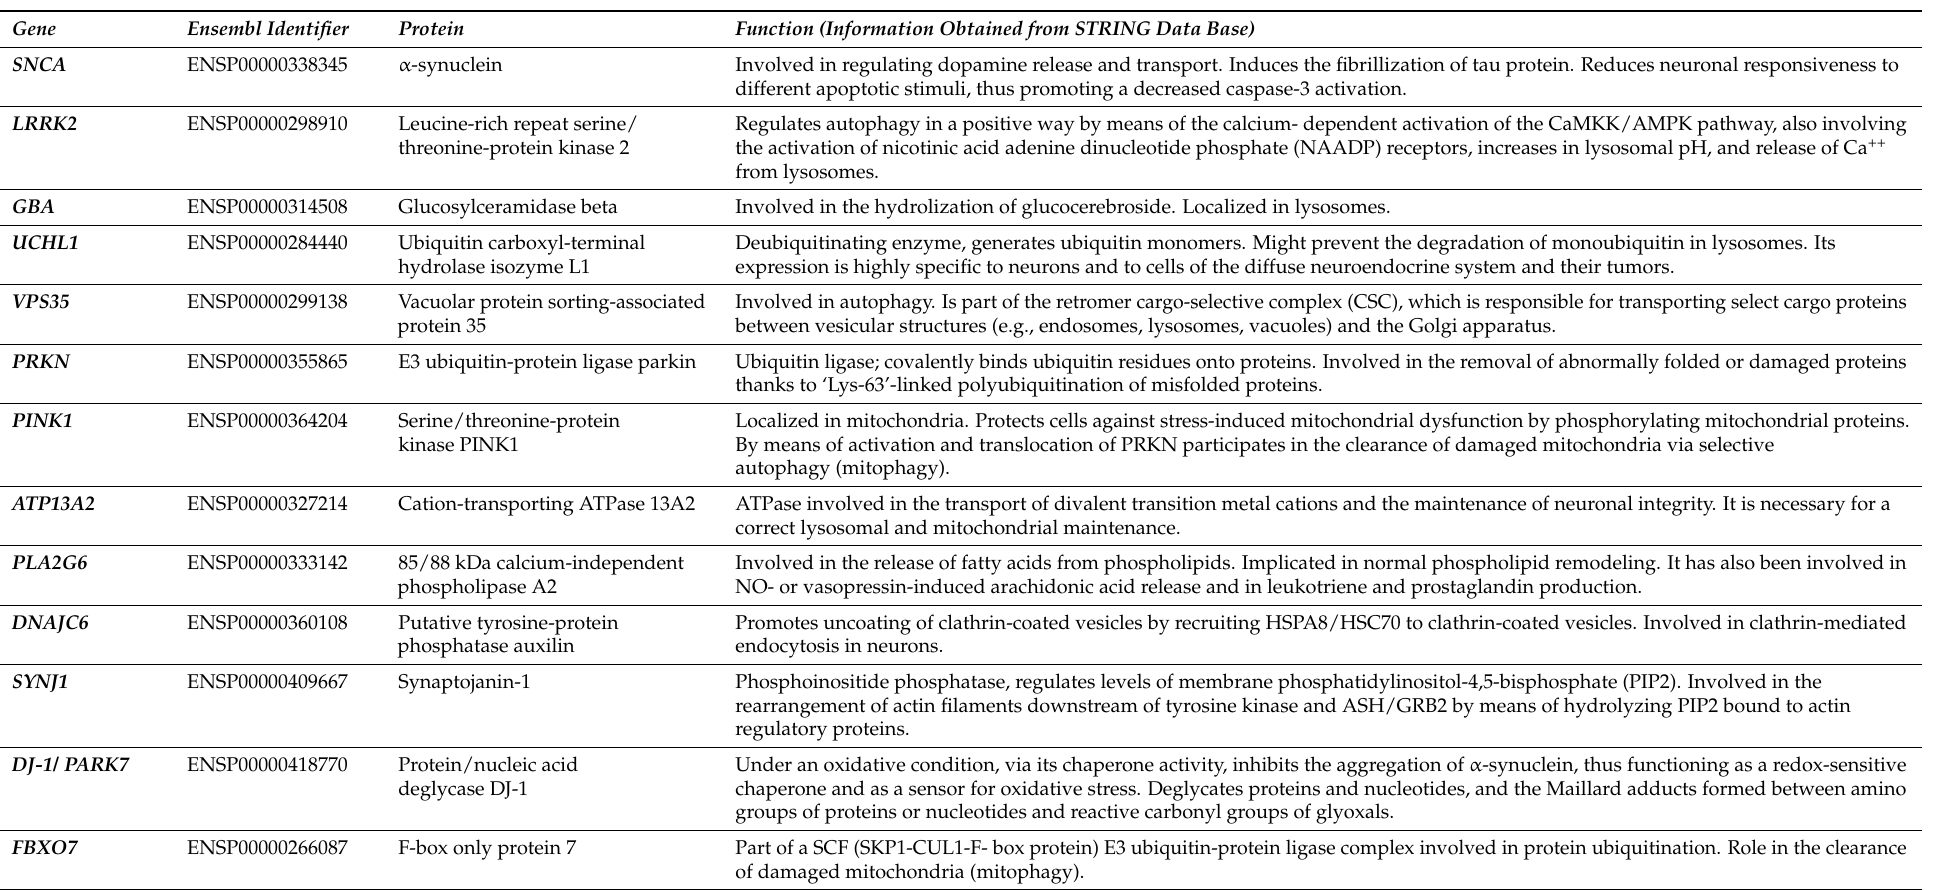
Table 2. Description of the products of the genes in Table 1. Function retrieved from https://string-db.org/ (accessed on 10 April